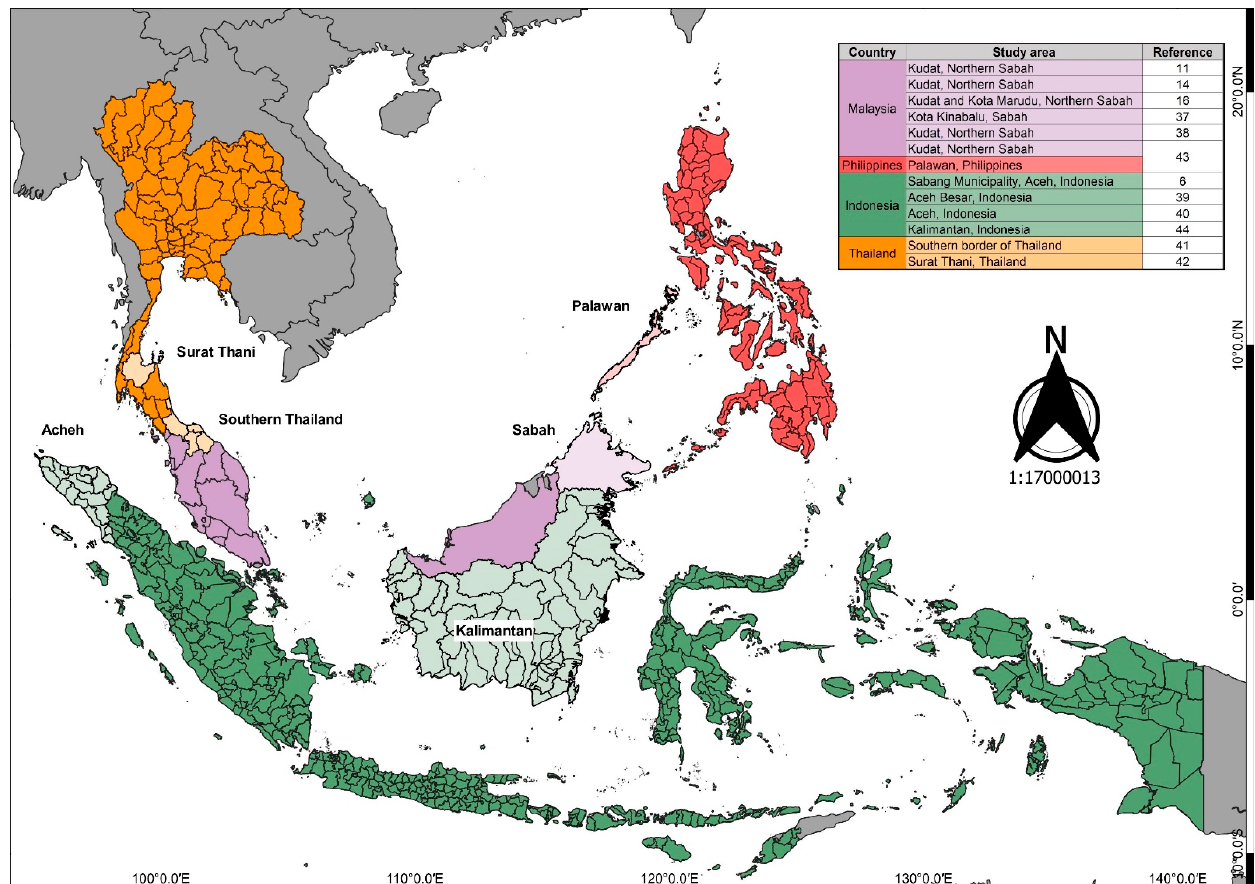
Figure 2. Map of study locations [6,11,14,16,37–44].